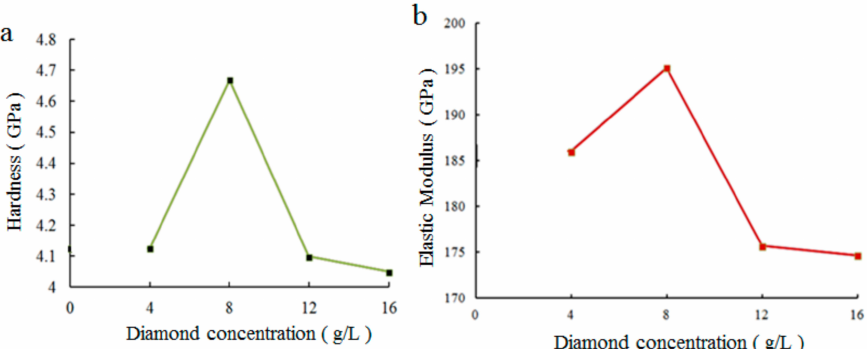
Figure 11. E ff ect of nanodiamond concentration on mechanical properties of composite coatings: ( a ) Hardness, and ( b ) elastic